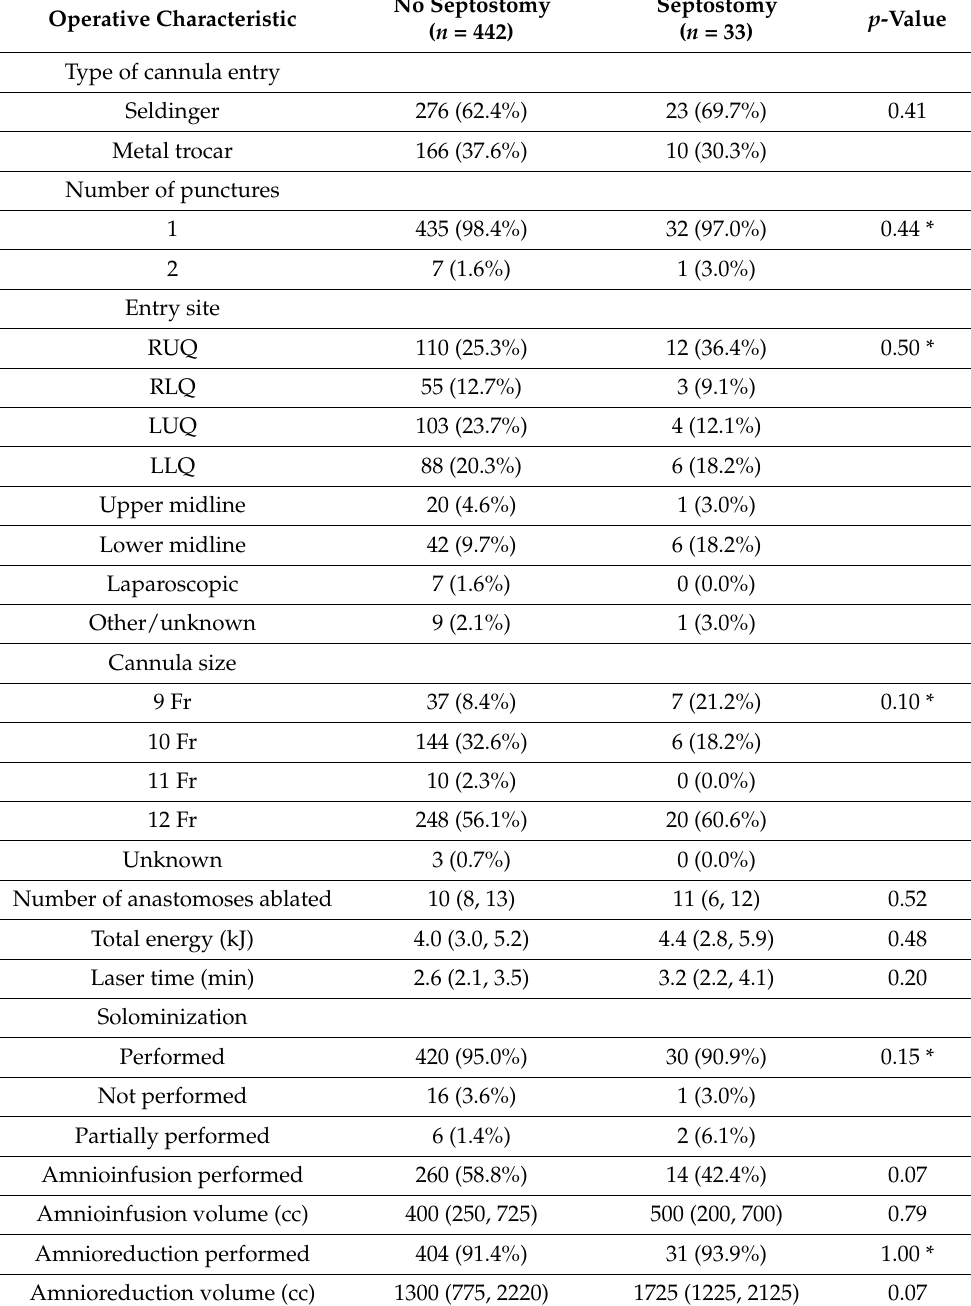
* Fisher’s exact test used due to small expected values in the contingency table. Data expressed as: n (%), median [1st quartile, 3rd quartile]. Abbreviations: LLQ—left lower quadrant, LUQ—left upper quadrant, RLQ—right lower quadrant, RUQ—right upper